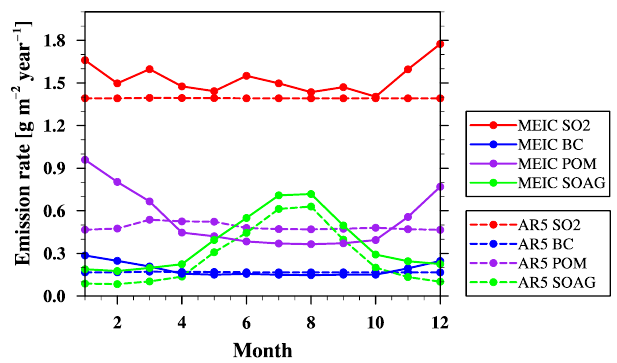
Figure 1. Seasonal variations of SO 2 , BC, POM, and SOAG in the MEIC emission and the AR5 emission in China for the year